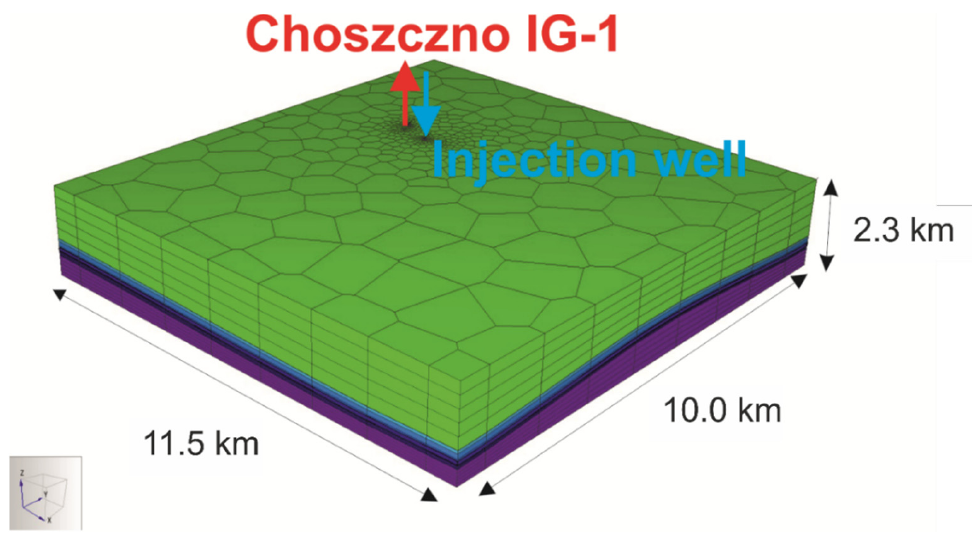
Figure 3. Numerical model of Choszczno region.